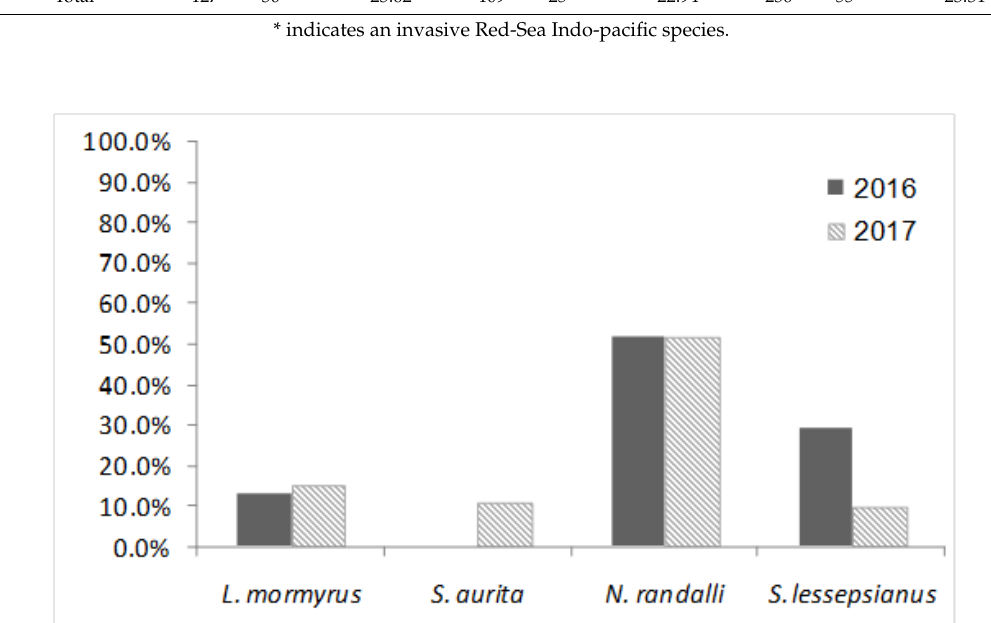
* indicates an invasive Red-Sea Indo-pacific species.